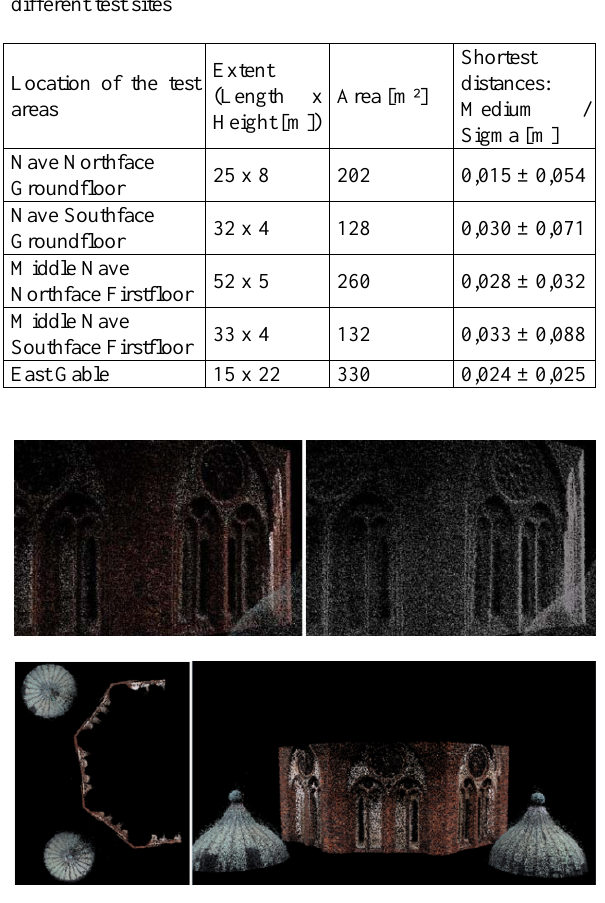
Table 1. Summary of the UAS - TLS differences at four